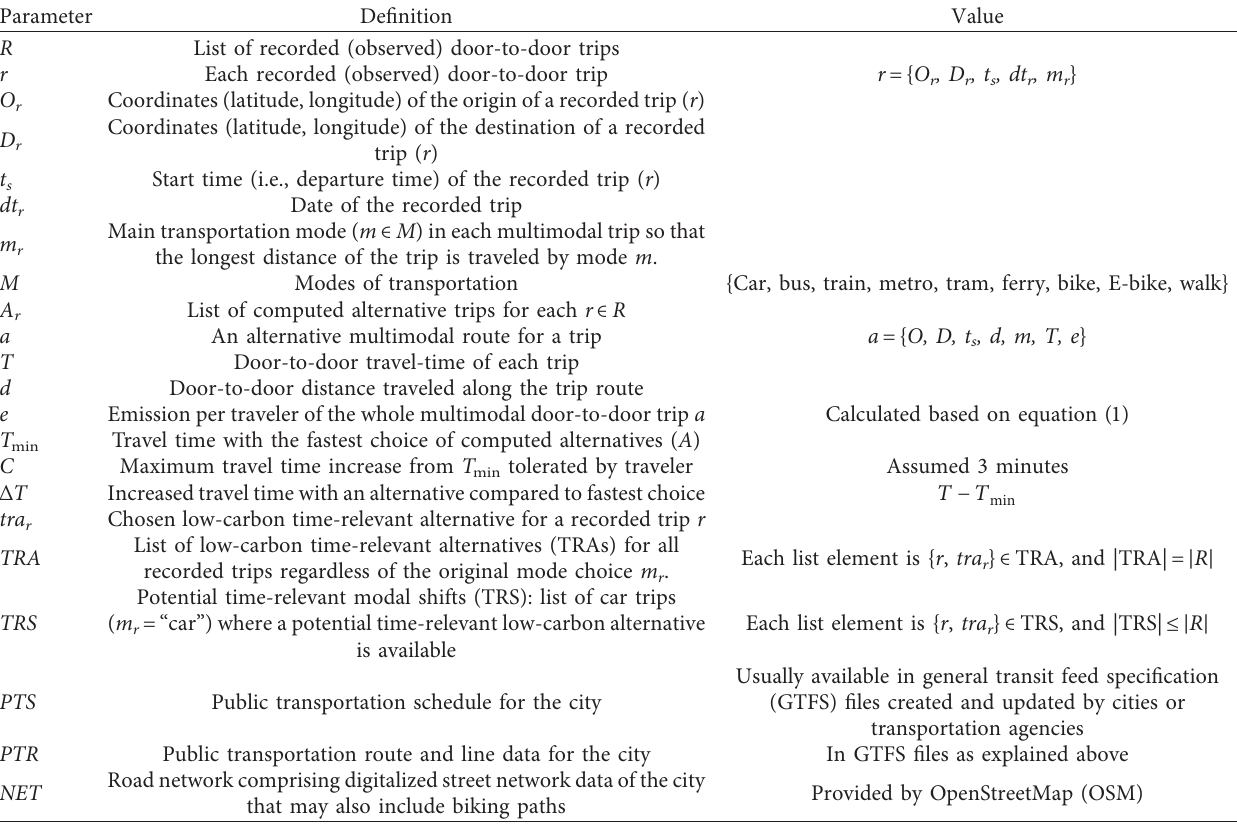
Table 2: Variables used in the